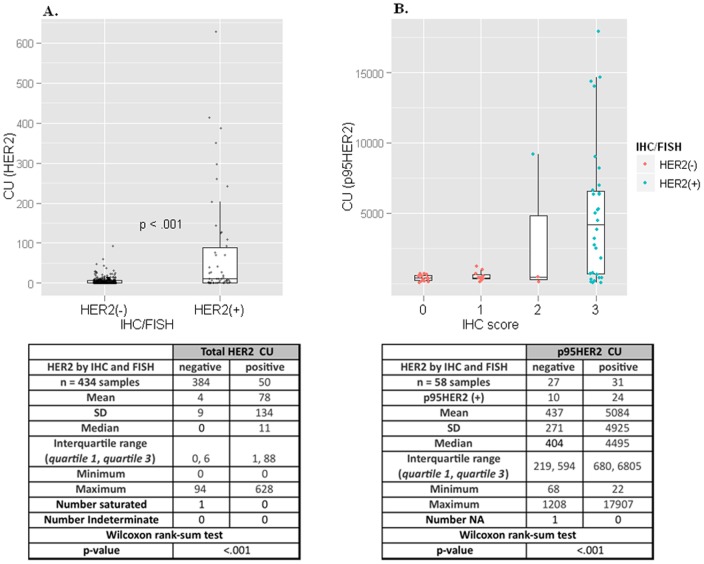
HER2 and p95HER2 expression in gastric cancers.(A) CU distribution for HER2 expression of GC samples at 0.25 µg lysate. The x-axis represents the IHC/FISH status, and the y-axis represents the CU values from CEER assay as determined from a BT474 standard curve. Separation is illustrated between the two groups with a median of 0 for the IHC/FISH negative population (384 of 434) compared to a median of 11 for the IHC/FISH positive population (50 of 434). One saturated sample, above the limit of quantitation and indicated as ‘Number saturated’ in the corresponding table, is not shown. Boxes represent the interquartile range, with the 75th percentile at the top and the 25th percentile at the bottom. The line in the middle of the box represents the median. Whiskers extend to the highest and lowest value within 1.5 times the interquartile range. P value<.001 was determined by Wilcoxon signed-rank test. (B) CU distribution for p95HER2 in a subset of the tumor samples (58 of 434) at 20 µg lysate. The x-axis represents the IHC status, and the y-axis represents the CU values from CEER assay for p95. Full length HER2 was removed by immuno-depletion prior to the assay. The data points are colored based on the HER2 status by IHC and FISH. As shown, one data point with an IHC of 2 was determined to be positive by FISH analysis. Of the 34 samples determined to be positive for p95 by CEER, 24 (71%) of them were HER2(+) by IHC/FISH. p95HER2 expression could not be determined in one sample which is indicated as ‘Number NA’ in the corresponding table.